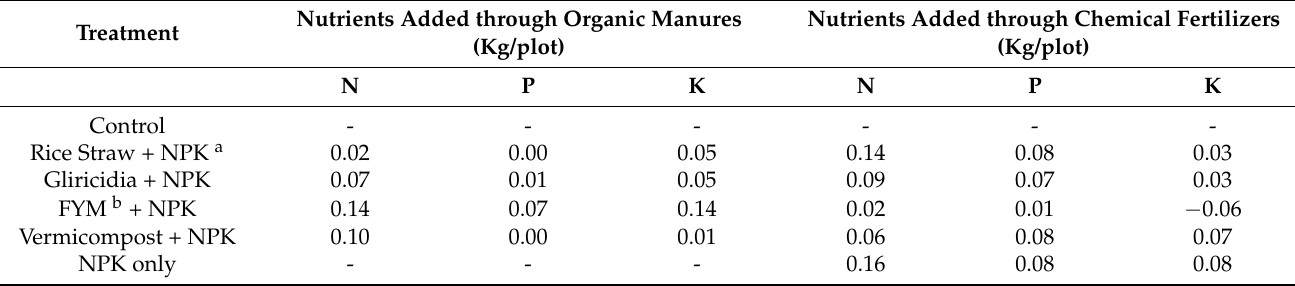
Table 3. Amounts of nutrients (nitrogen, phosphorous and potassium) (Kg/plot) added by organic manures and chemical fertilizers for each